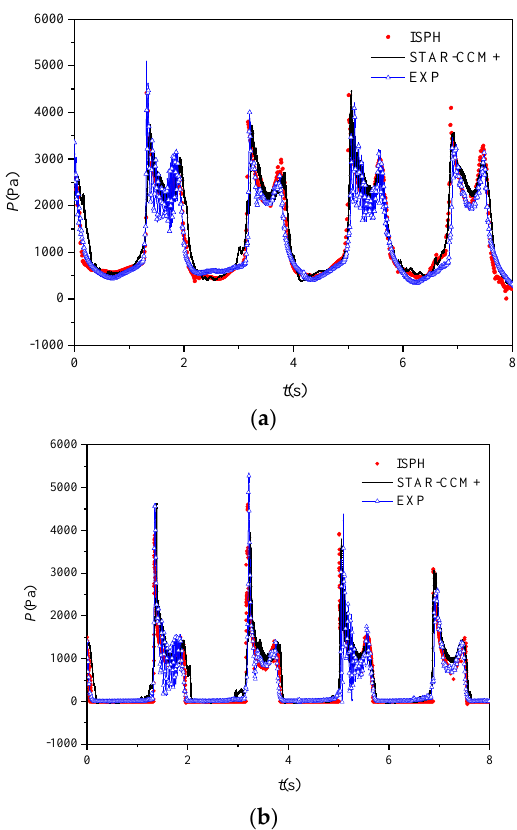
Figure 3. Comparisons of pressure time history between ISPH, STAR-CCM+ numerical results and experimental data of Liao and Hu [27] at: ( a ) P1; ( b ) P2.